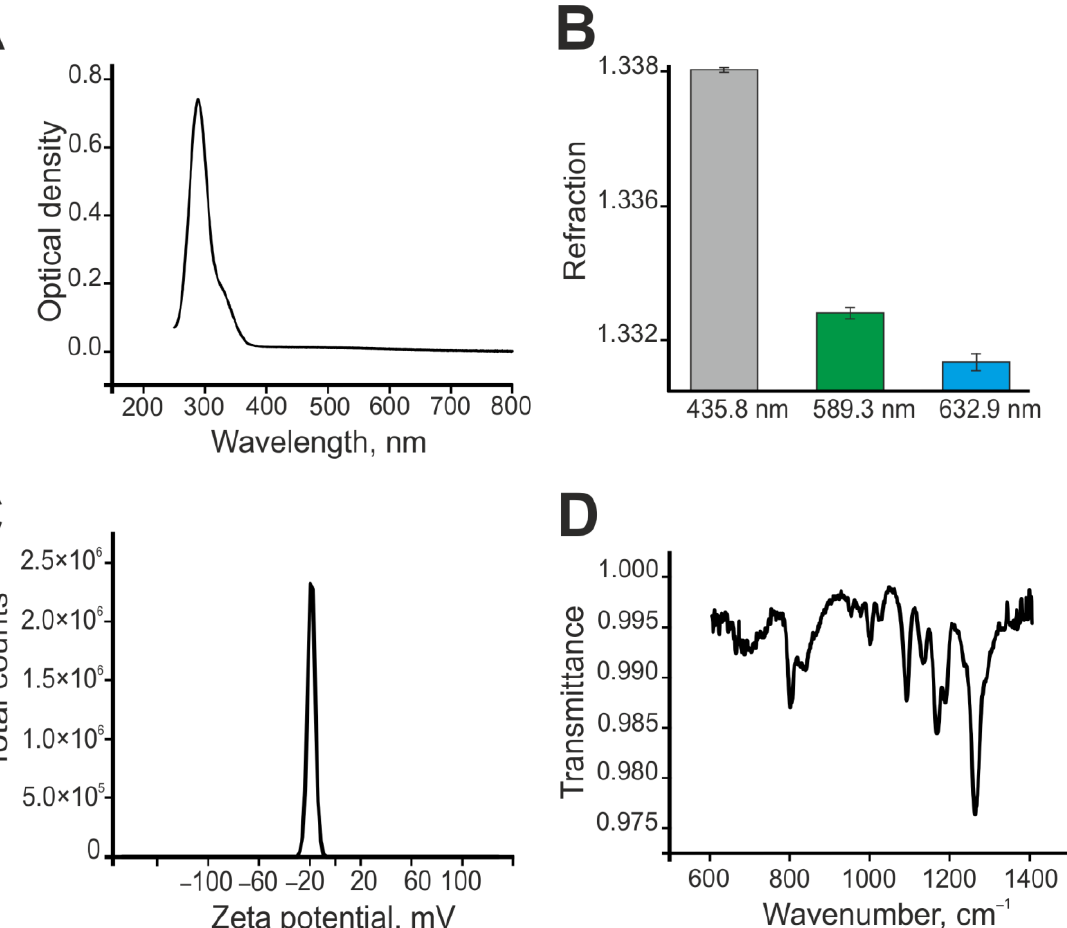
Figure 2. Shape, chemical composition, and size distribution of SeNPs and Se – TAX. ( A ) The